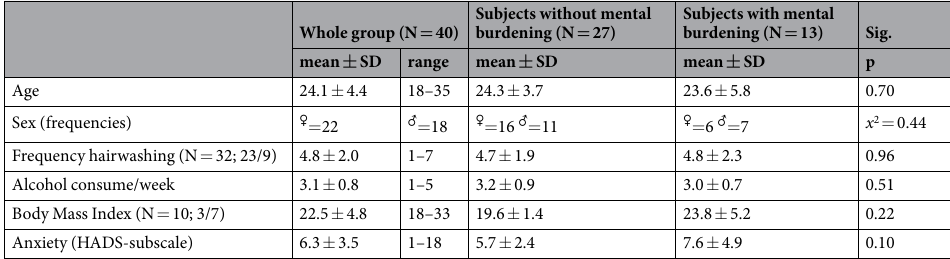
Table 1. Sociodemografic data of stress- and hair- related characteristics in subjects with and without mentally burdening events in the previous 3